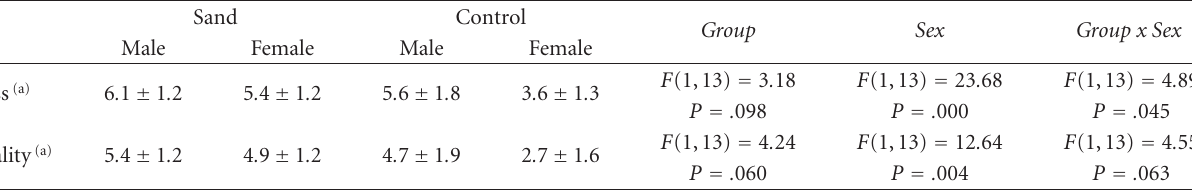
Table 2: Mass and overall quality of the furs (10-point scale; 1 = poorest, 10 = best; mean ± SD) of juvenile blue foxes in the Sand and Control groups.